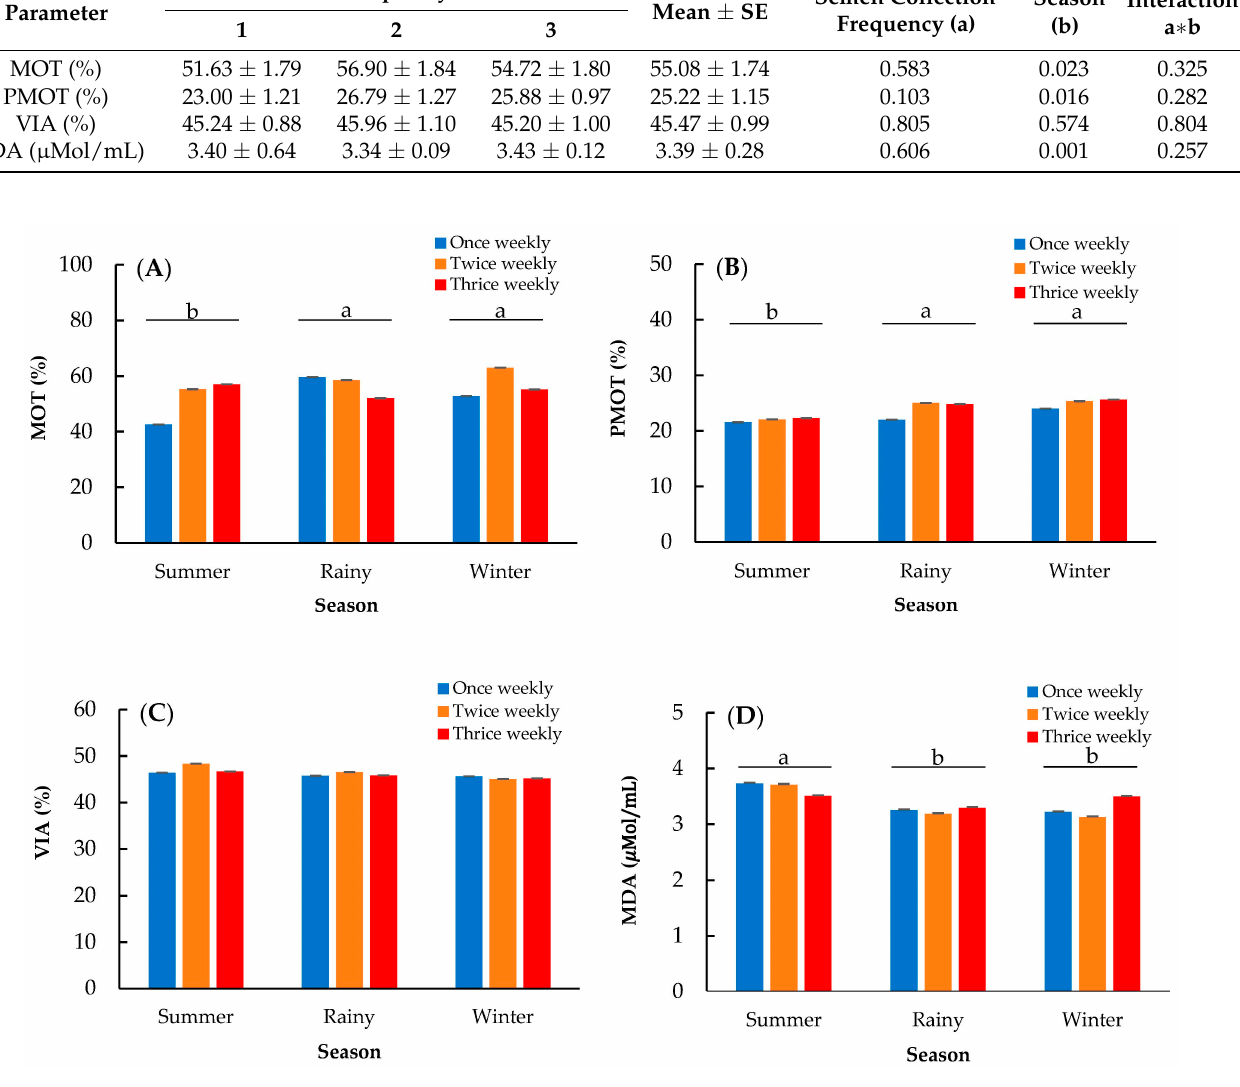
Figure 3. Effect of season on total motility (MOT; ( A )), progressive motility (PMOT; ( B )) sperm viability (VIA; ( C )), and malondialdehyde (MDA; ( D )) concentration in frozen-thawed rooster semen. a, b means followed by different letters differ significantly among seasons at p < 0.05 .